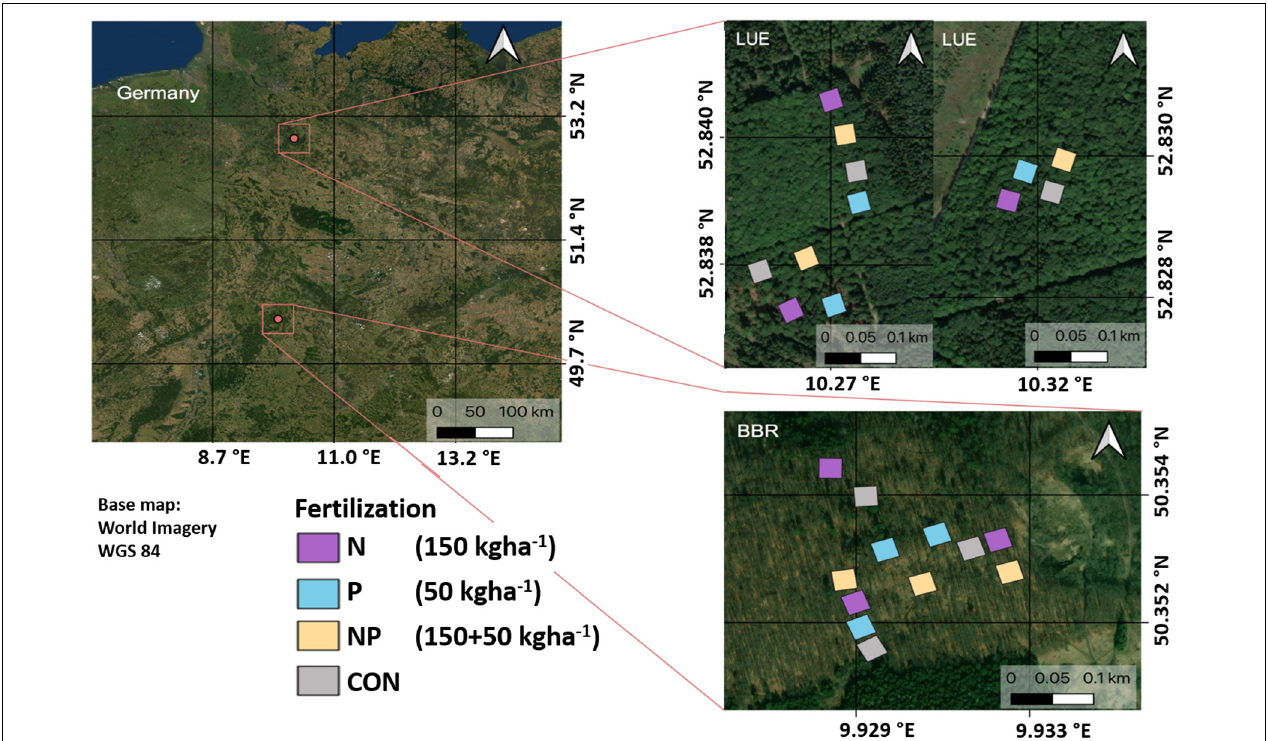
FIGURE 1 | Sitemap: experimental design of the fertilizer treatments (done in triplicate). The amount of fertilizer applied is given in brackets in kg ha - 1 year - 1 . Nitrogen (N) and phosphorus (P) were applied as NH 4 NO 3 and KH 2 PO 4 , respectively. Note that the control and N treatment received KCl to ease comparison with the P treatment which included the addition of K as well. Courtesy by Jaane Krüger; Source: Esri, Maxar, GeoEye, Earthstar Geographics, CNES/Airbus DS, USDA, USGS, Aerogrid, IGN, and the GIS User Community. To minimize visual distance of one triplicate of fertilized plots in LUE the coordinate system is adapted adequately, BBR = Bad Brückenau; LUE =